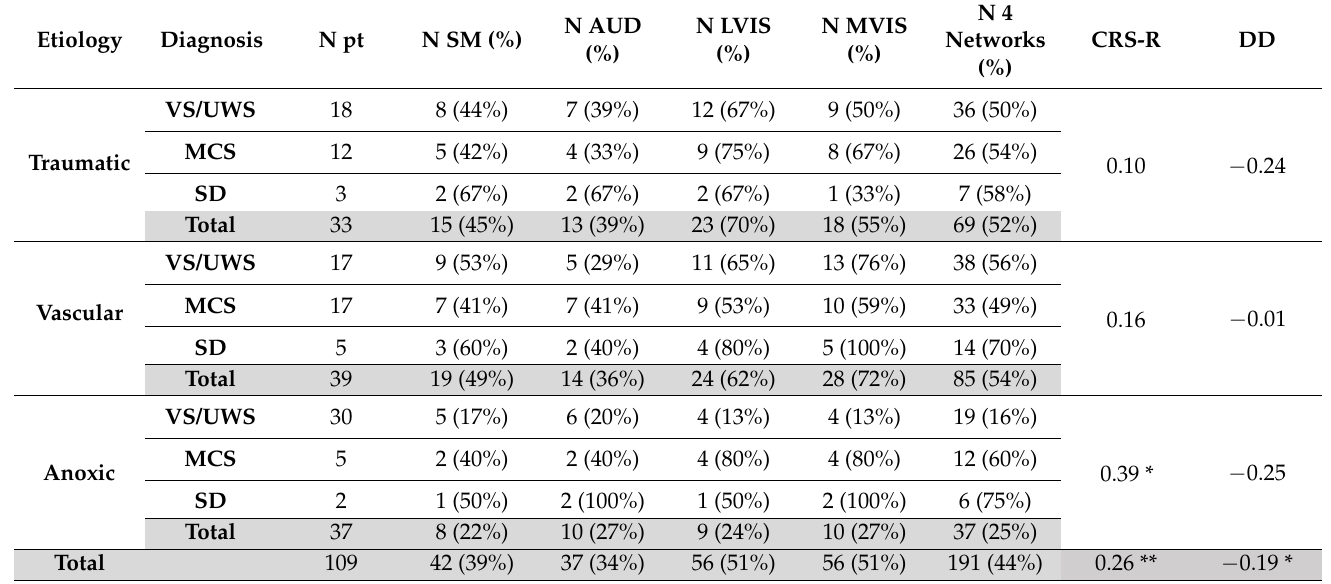
Table 7. Number of networks (with percentage) identified for VS/UWS, MCS and SD patients for the 3 etiologies and the correlation of the number of networks with CRS-R total score and disease duration (DD) measured with Spearman